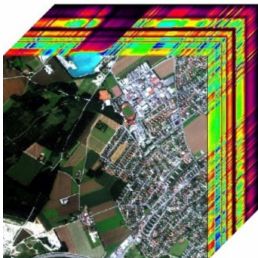
Figure 2. Data cube provided by a spectrometer under the hyperspectral imaging technique